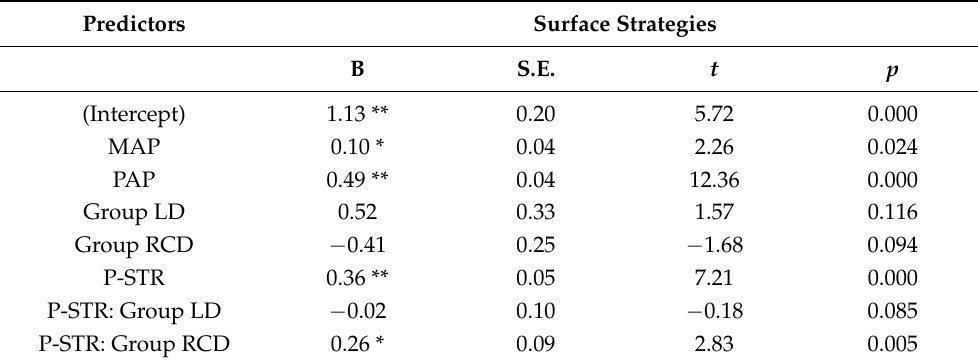
Table 4. Model 8: Linear regression analysis for predicting surface